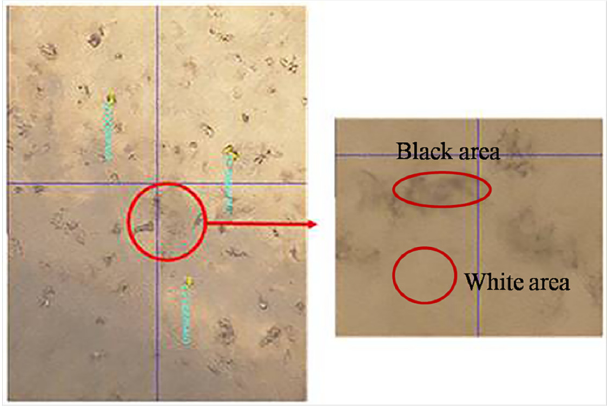
Figure 9. Inlays in the epoxy resin microcapsule reunion.